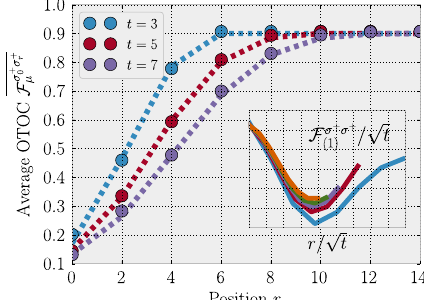
FIG. 13. Comparison of the perturbative expansion to TEBD results at short times for the average ˆ σ þ ˆ σ þ OTOC at chemical potential μ ¼ 3 . Dots, TEBD results averaged over 100 circuits; dashed lines, perturbative expansion at O ð e − μ Þ . The perturbative result agrees very well with the TEBD numerics up to the times considered. Inset: The O ð e − μ Þ correction to the OTOC F observe an approximate collapse of the data when F plotted as a function of r= diffusive in nature.